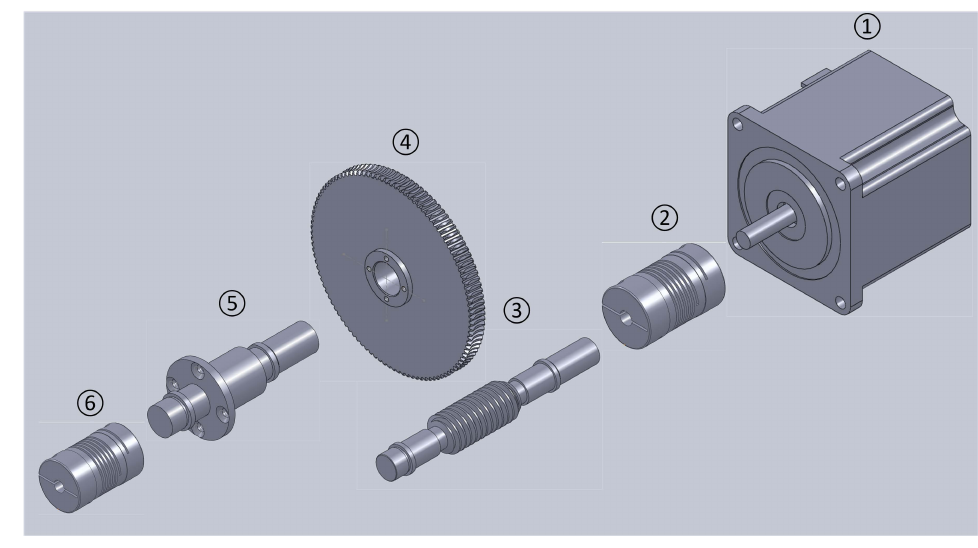
Figure 5. The mechanical